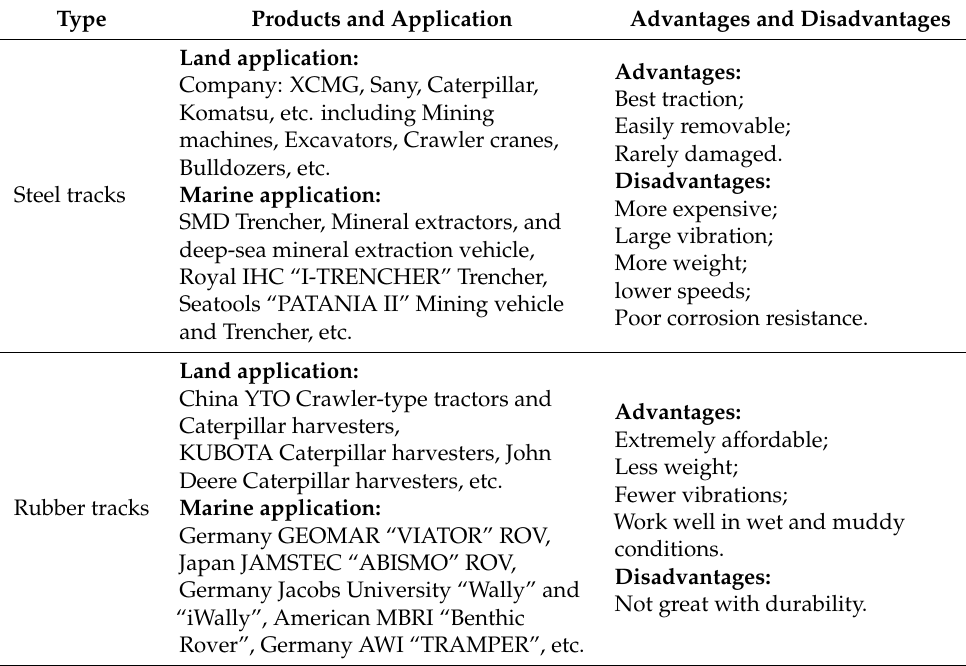
Advantages and Disad-